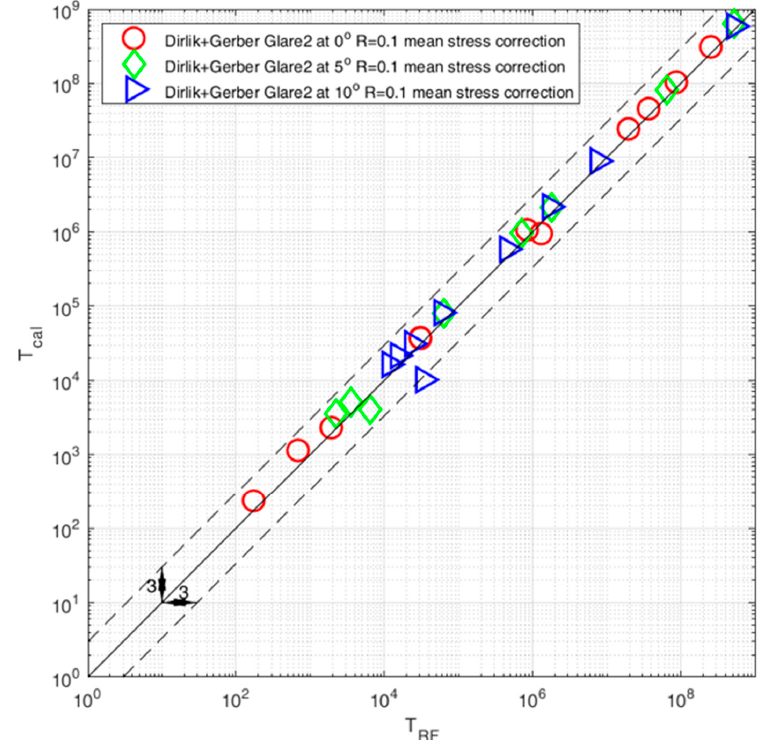
Figure 10. Comparison of fatigue life calculated with the use of the rainflow cycle counting method and the spectral method with the use of the Dirlik model with mean stress compensation with the Gerber model for three fiber orientations θ = 0°, θ = 5°, and θ = 10°.